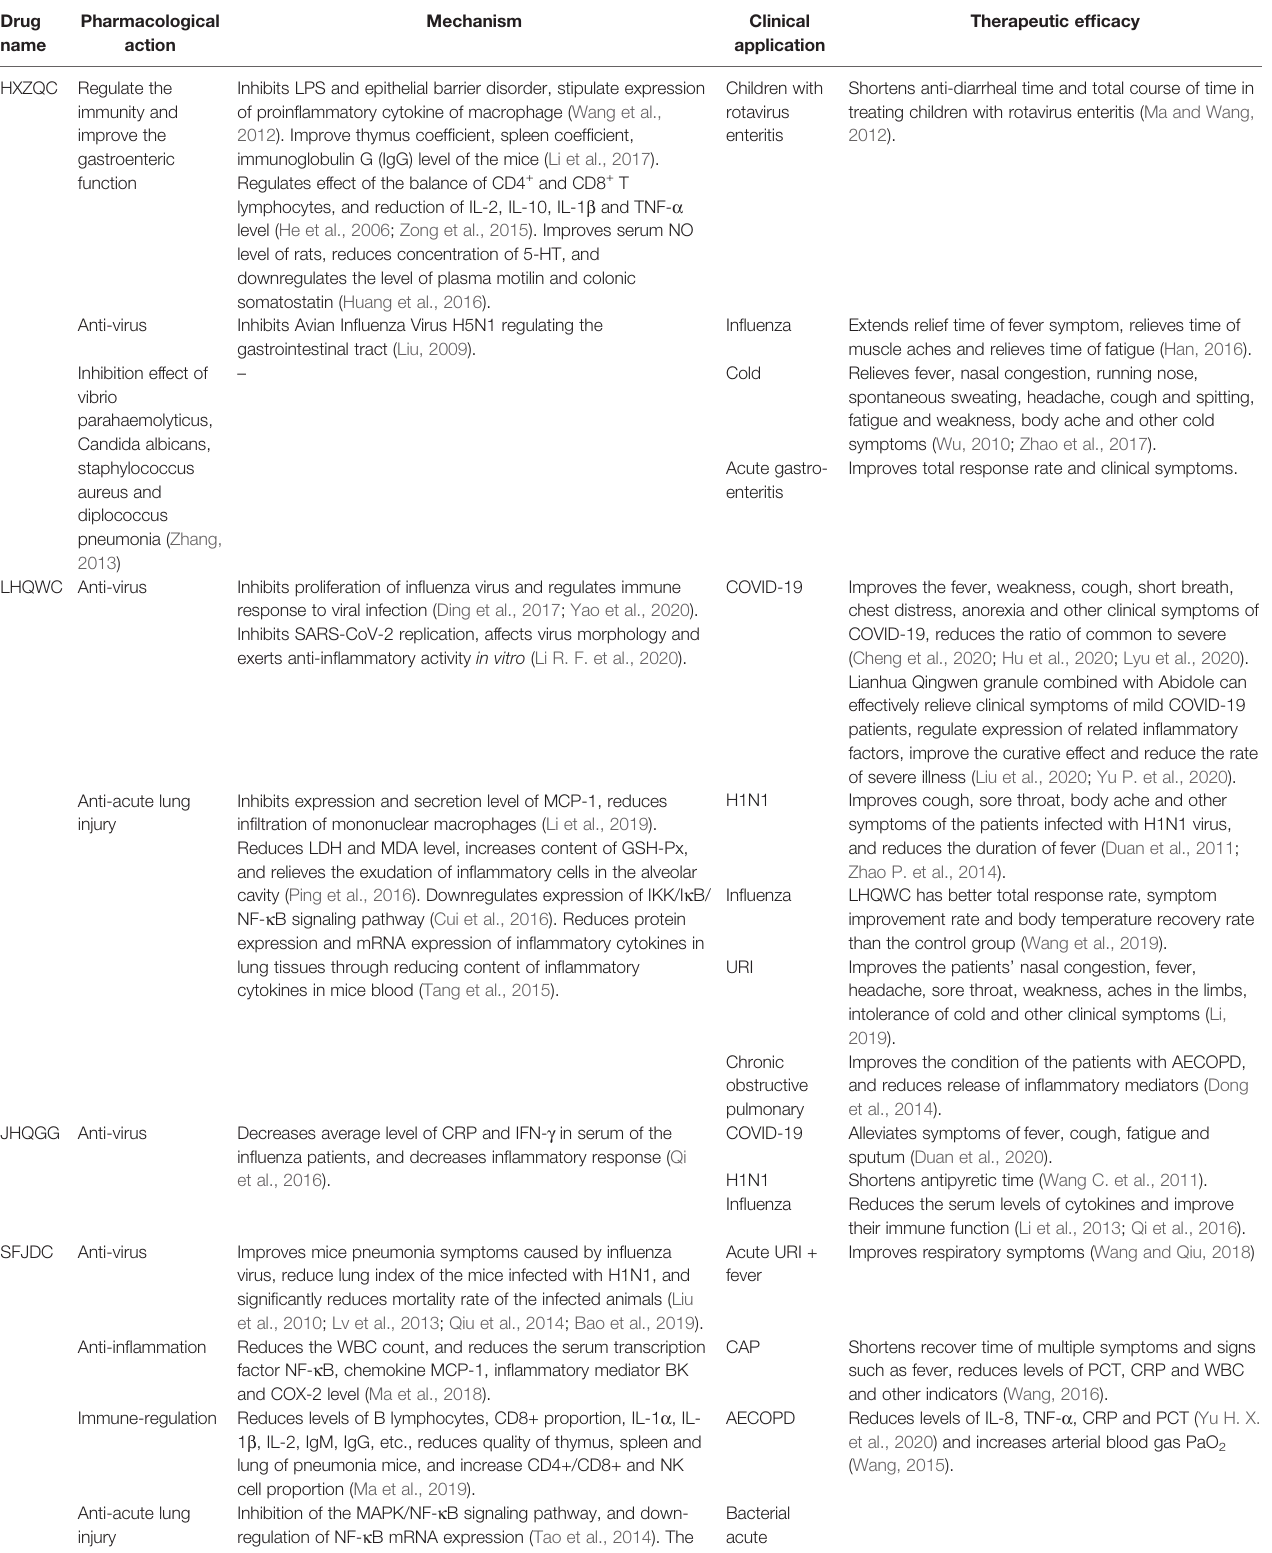
TABLE 3 | Pharmacological functions and clinical research on top 10 CPMs for the treatment of COVID-19. Drug